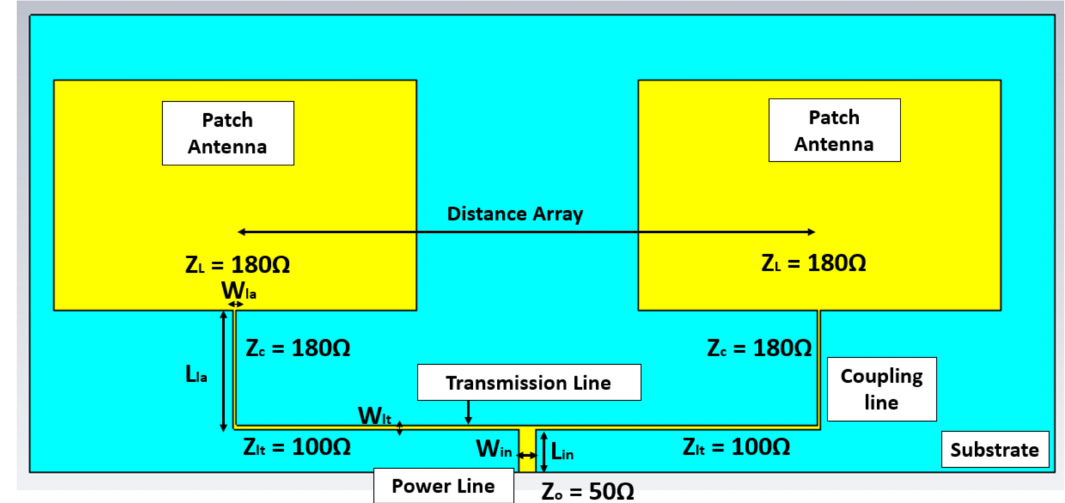
Figure 19. Design of the patch array antenna 2 × 1 and InsetFeed.